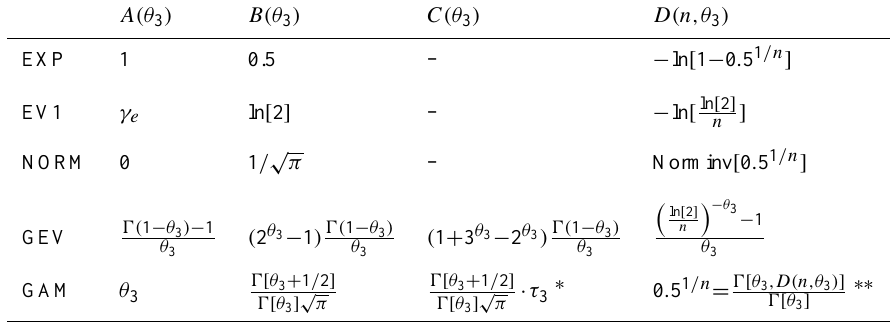
Table 2. Distribution dependent functions to be used for parameter estimation, as defined in Eqs. (6 and 10). 0 [·] is the gamma function, 0 [·;·] is the incomplete gamma function, and Norminv is the inverse of the standardized Gaussian cumulative distribution function. A(θ 3 ) B(θ 3 ) C(θ 3 ) D(n,θ 3 ) EXP 1 0.5 – − ln [ 1 − 0 . 5 1 /n ] ] EV1 γ e ln [ 2 ] – − ln [ ln [ 2 ] n √ π – Norminv [ 0 . 5 1 /n ] NORM 0 1 /